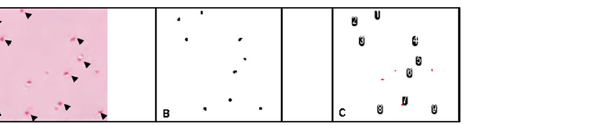
Fig 3. Viable chondrocyte selection and quantification in FIJI using the Threshold Colour plugin. A) Subset of nuclear fast red stained chondrocytes. Black arrows indicate viable chondrocytes. B) Thresholded, viable chondrocytes. Note the elimination of non-viable chondrocytes and extracellular matrix. C) Count of thresholded, viable